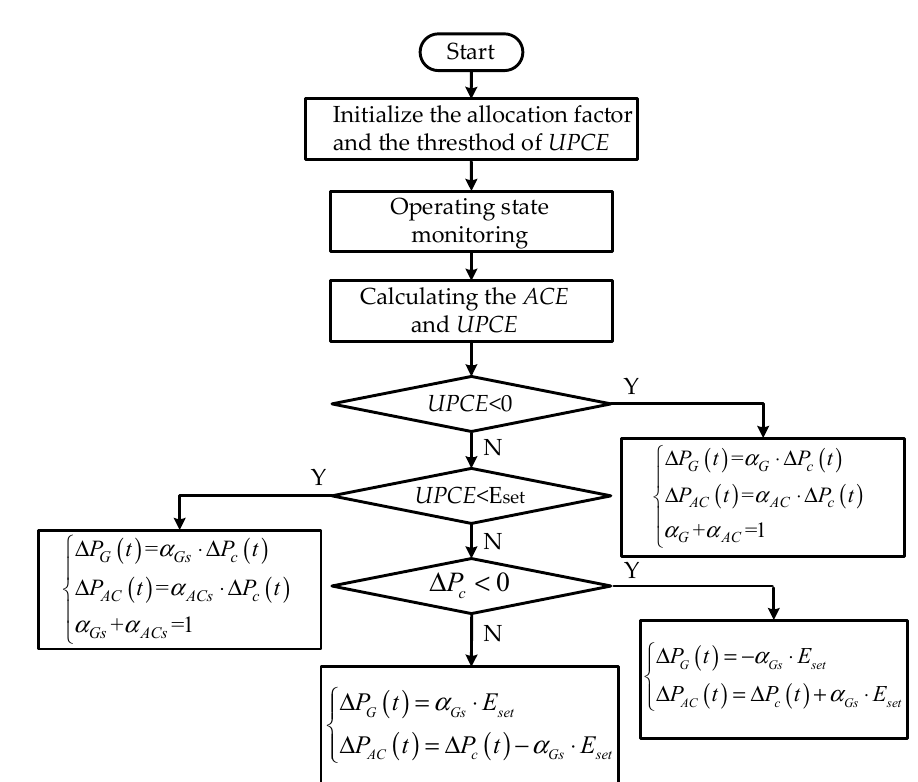
Figure 2. The dynamic allocation method based on UPCE.